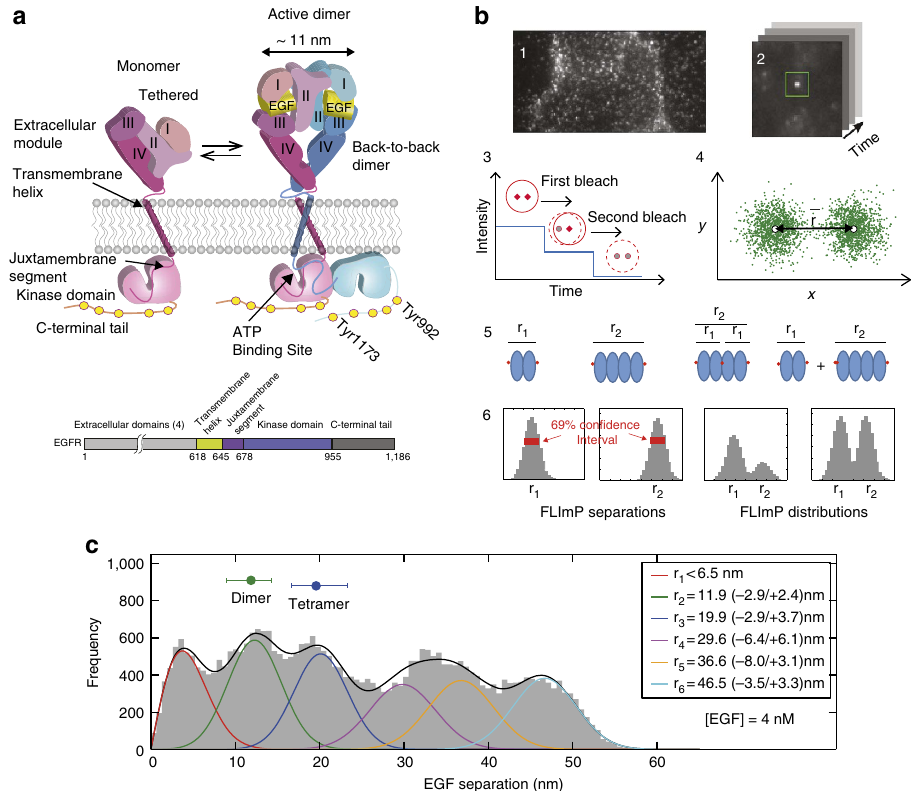
Figure 1 | FLImP measurement of pairwise EGF separations. ( a ) Cartoon of an EGFR monomer, a two-ligand active dimer, and an EGFR sequence diagram. ( b ) Steps to determine EGF separations using FLImP 15 : (1) TIRF images are collected from intact cells; (2) spots from individual complexes are tracked to derive intensity time courses; and (3) a spot image of a complex containing two fluorophore-conjugated EGF ligands (red dots) features two intensity levels and decays to zero in two bleaching steps; when one fluorophore bleaches, the centroid position shifts. If more than two steps occur, the lowest two are analysed. (4) A global least-squares seven-parameter-fit is used to identify the best intensity, x - y positions and the full-width at half-maximum of the point ffiffiffiffiffiffiffiffiffiffiffiffiffiffiffiffiffiffiffiffiffiffiffiffiffiffiffiffiffiffiffiffiffiffiffiffiffiffiffiffiffiffiffiffiffi q spread function for each fluorophore, from which their separation ð r ¼ ð x 1 (cid:2) x 2 Þ 2 ¼ ð y 1 (cid:2) y 2 Þ 2 Þ is calculated with a precision determined by the localization error; (5) Example systems of a two-ligand dimer and tetramer, a three-ligand tetramer, and a mixture of a dimer and a tetramer. (6) The empirical posterior distributions (or FLImP measurement) of pairwise ligand separations obtained for each example system with their 69% confidence intervals highlighted. The size of the latter depends on the combined localization errors of the two molecules 15 . FLImP measurements with confidence intervals smaller than the required resolution are retained in a histogram, generating a so-called FLImP distribution that is fitted by the sum of a discrete number of Rician peaks (Supplementary Fig. 3a). ( c ) FLImP distribution (grey) of CF640R fluorophore-conjugated EGF on CHO cells ( B 10 5 copies of wild-type EGFR per cell) treated with 4nM EGF at 4 (cid:2) C with chemical fixation, compiled from 30 FLImP measurements with confidence intervals o 4.8nm. The distribution is decomposed into a sum of six Rician peaks. Positions and error estimates are shown in the inset. (Details in Supplementary Methods.) The peak positions (and error bars) reflecting the expected dimers and tetramers are marked above the plot. The optimal number of peak components (colour lines) and the best-fit (black line) were determined using a Bayesian information criterion and Bayesian parameter estimation (Supplementary Figs 3b and 4a, and Supplementary Methods).